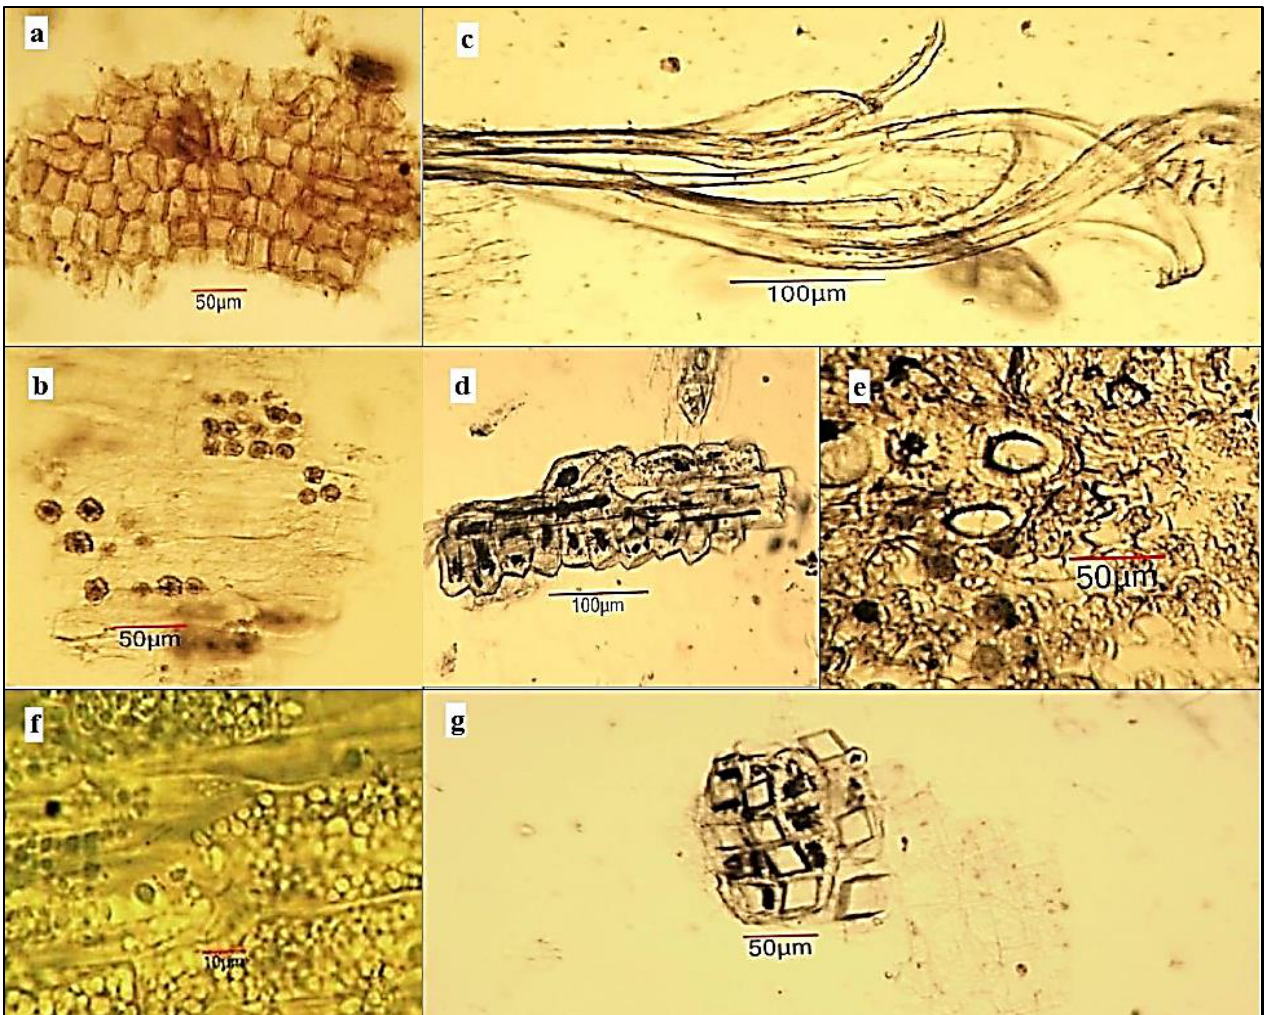
Figure 3. Microphotos of powdered stem bark substance of Ailanthus altissima : ( a ) cork on surface view; ( b ) phloem parenchyma with crystalline druses; ( c ) phloem fiber bundle; ( d ) sheath of sclereids around phloem fibers; ( e ) fragment of phloem with schizogenous oil gland; ( f ) fragment